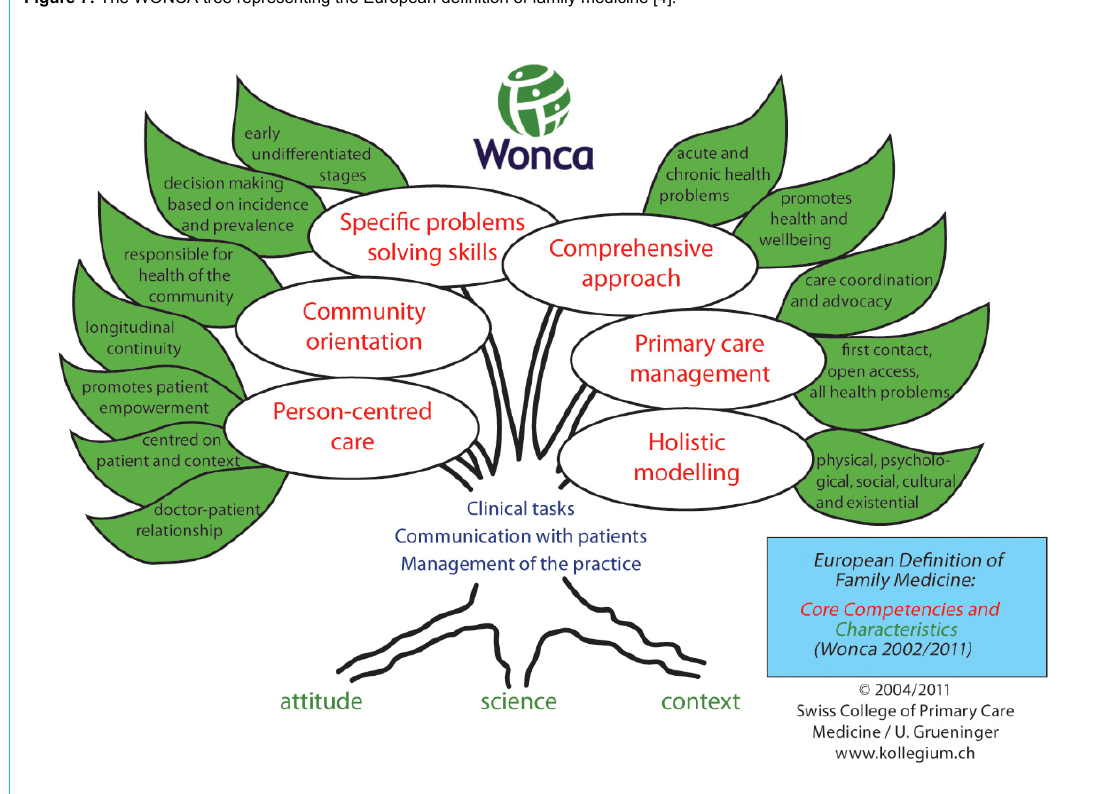
Figure 7: The WONCA tree representing the European definition of family medicine